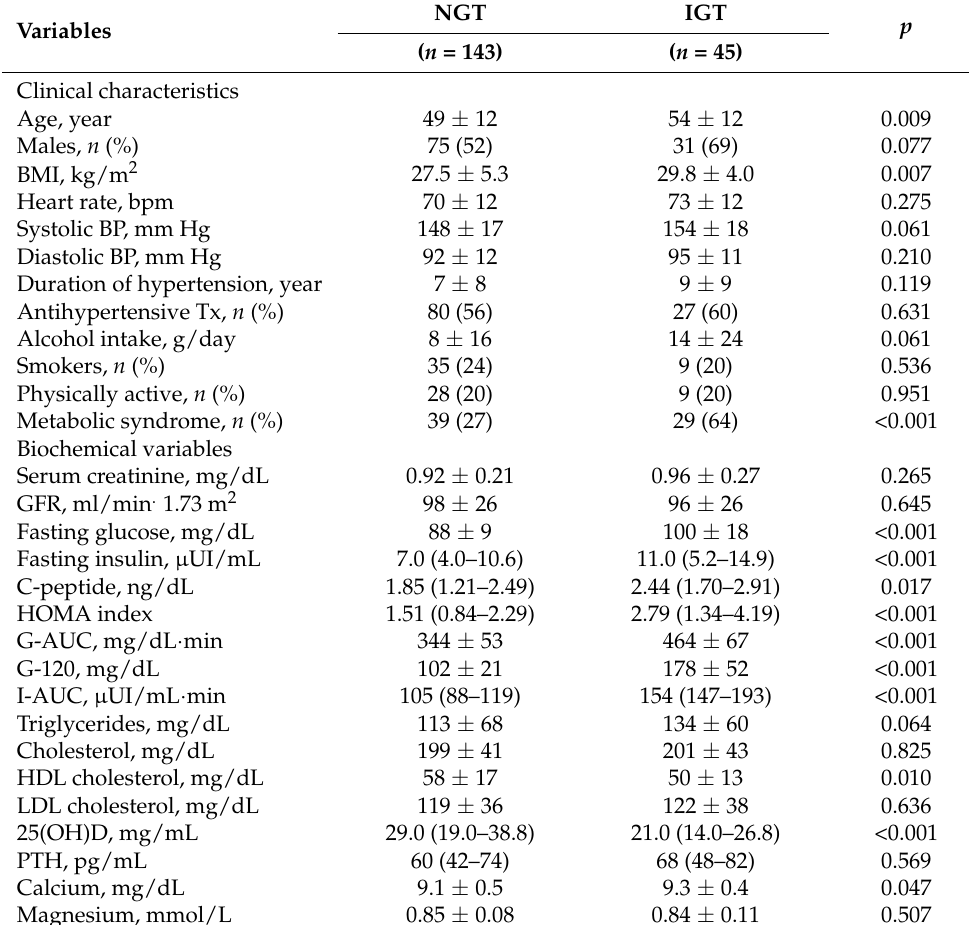
Table 2. Clinical characteristics and biochemical variables of the study patients according to normal (NGT) or impaired (IGT) glucose tolerance. Variables